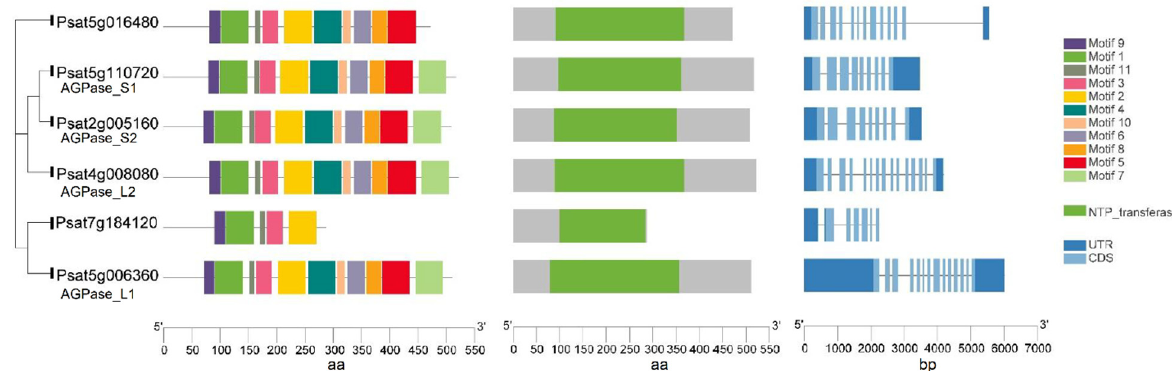
Figure 2. Gene structure, functional domains and conserved motifs in putative ADP-Glucose-Pyrophosphorylase (AGPase)